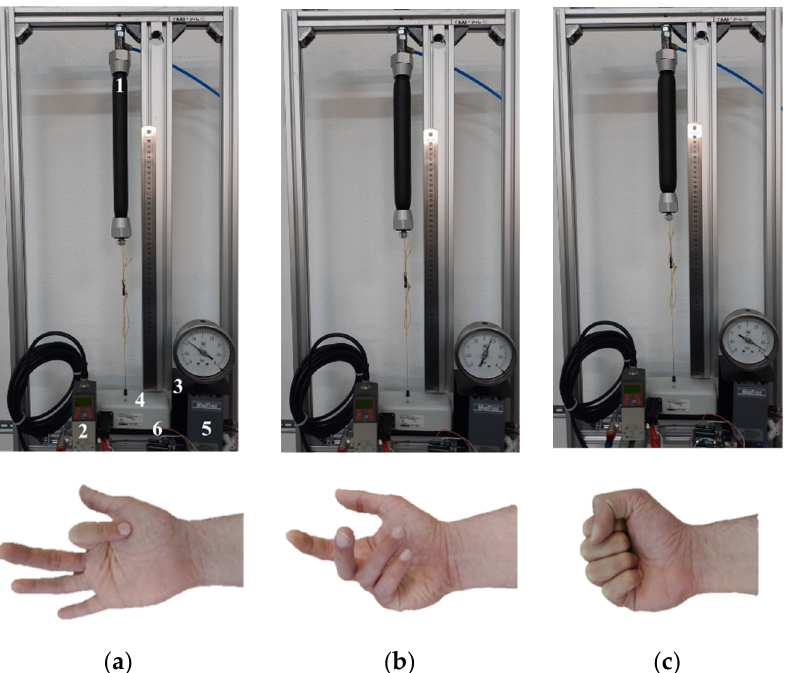
Figure 11. Testbed for the experimental application: (1) pneumatic muscle; (2) proportional pressure control electro-valve; (3) manometer; (4) wire linear position transducer; (5) Myotrac sensor; (6) Arduino Uno. Three pressure levels have been associated with the three finger movements: ( a ) first, ( b ) second and ( c ) third movement.